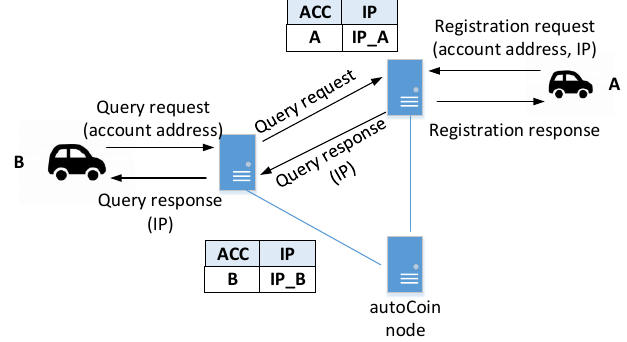
Figure 4. URI resolution service by blockchain